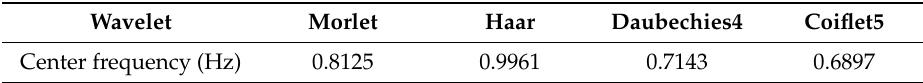
Table 1. Center frequency of the wavelets used in the current